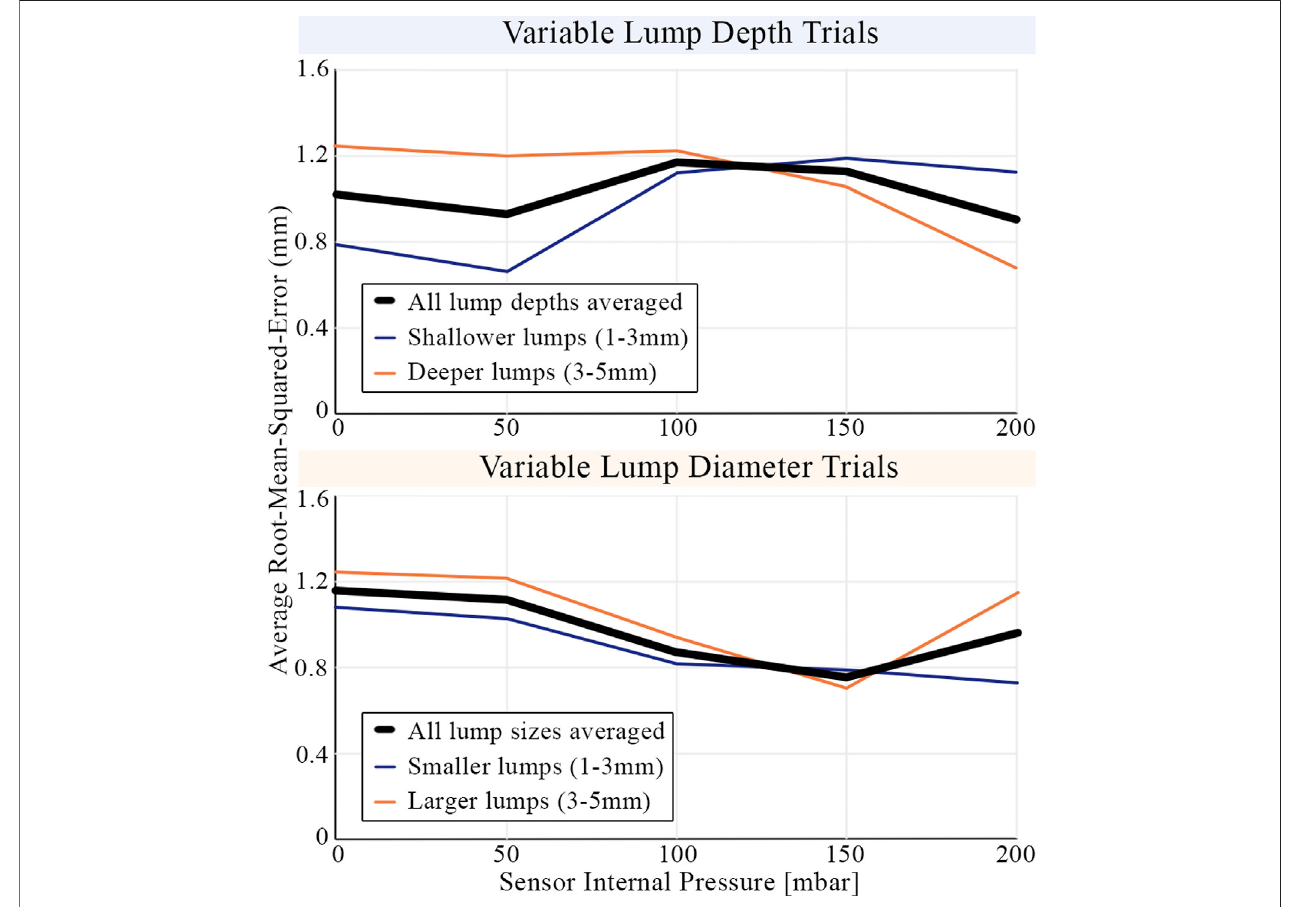
FIGURE 14 | The average root-mean-squared-error in classifying embedded lumps by their size and depth. Results are shown averaged across all indentation forces (1 . 6 N to 8 N ). Additional lines are plotted averaged across different subsets of embedded lump trials to highlight differences in behavior. The sensor ’ s accuracy in identifyingthesizeanddepthofembedded lumps variesastheinternalpressureofthesensor,and thereforetheeffective stiffnessofthetactilemembranes,isadjusted.